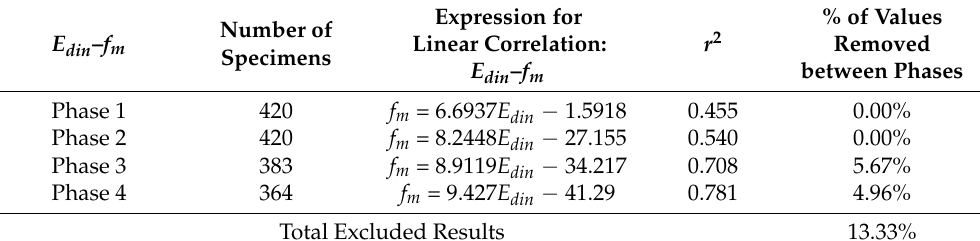
Figure 7. Correlation between dynamic modulus of elasticity ( E din ) and bending strength ( f m ). ( a ) With the moisture content at the time of the tests (Phase 1); ( b ) After the correction for a 12% of moisture content (Phase 2); ( c ) After excluding the outliers (Phase 3); ( d ) After excluding 5% of the values farthest from the linear regression expression.